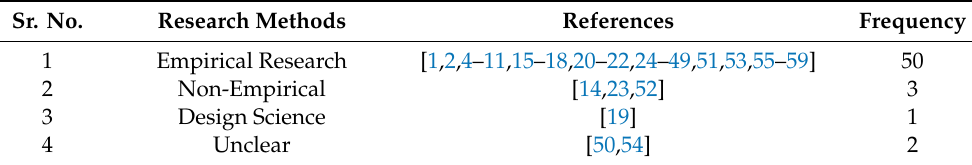
Table 5. Overall Classification of